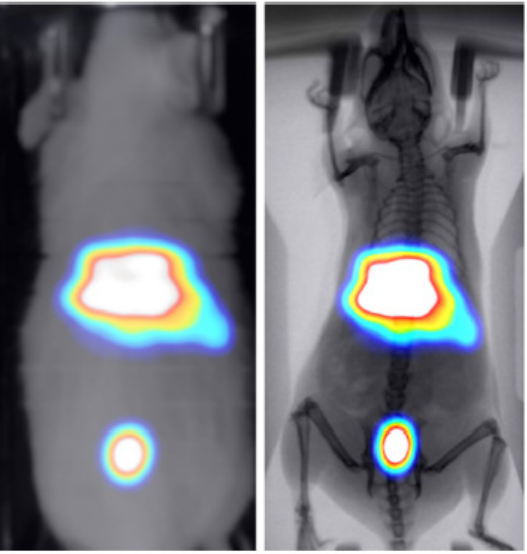
Figure 7. 99 m Tc -MDP-labelled nuclear image of a healthy mouse fused with the optical image provided in the γ -eye scintigraphic system ( left ) and the X-ray produced from the pix2pix trained network ( right ).